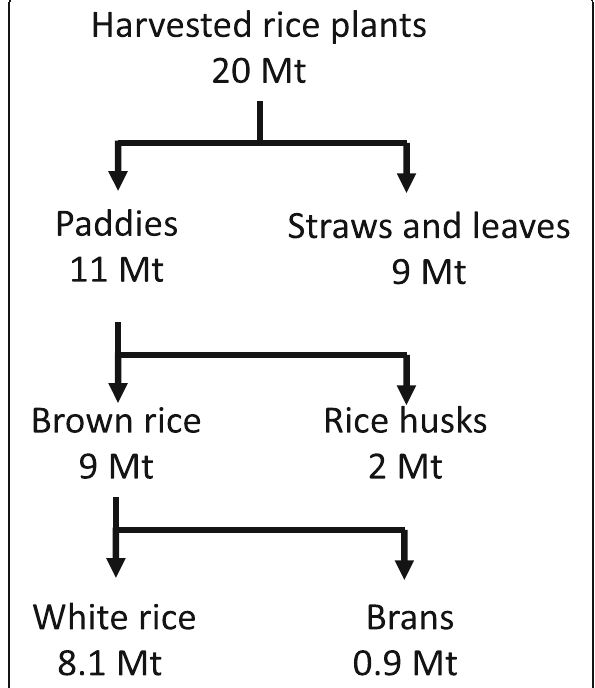
Fig. 3 Distribution of rice plants at each step post-harvest (numbers shown are approximate actual tons)